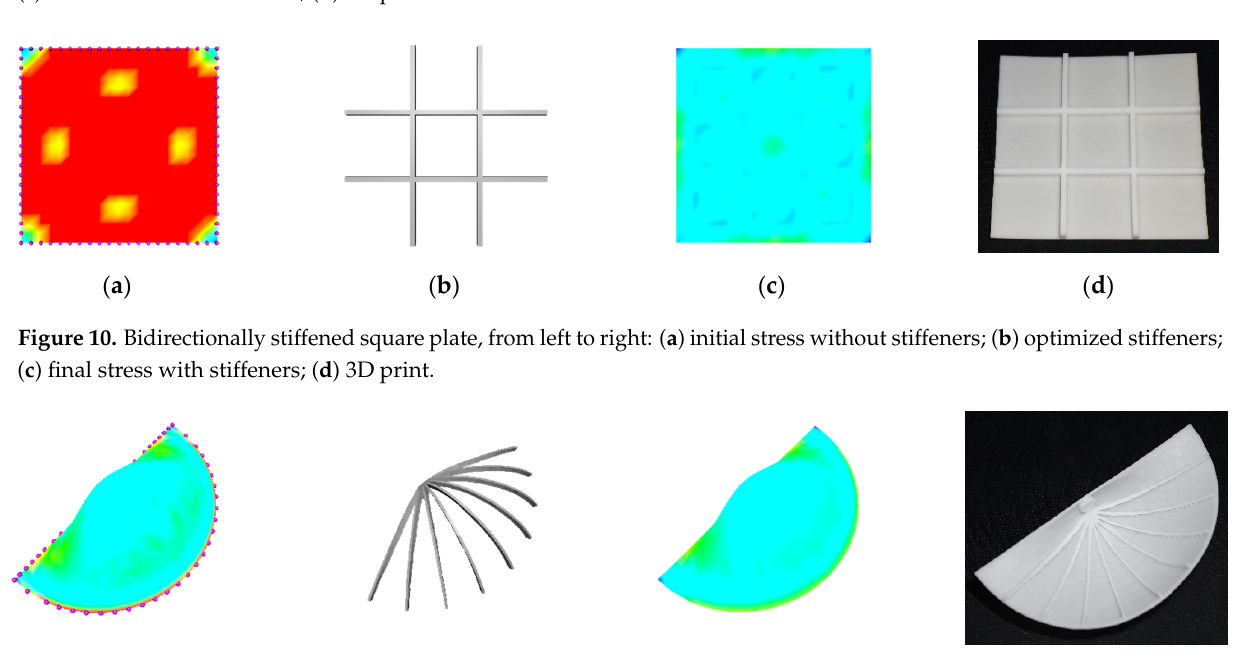
Figure 9. Unidirectionally stiffened flat plate, from left to right: ( a ) initial stress without stiffeners; ( b ) optimized stiffeners; ( c ) final stress with stiffeners; ( d ) 3D print.